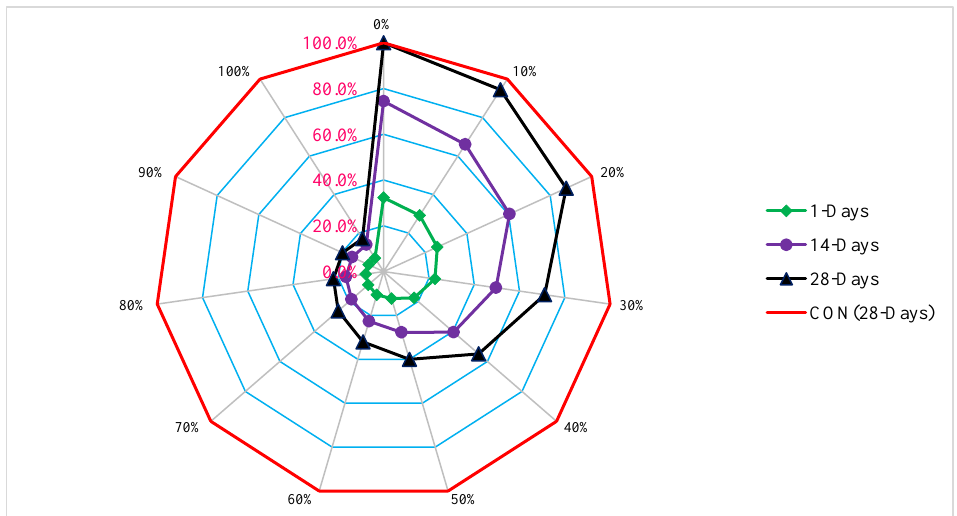
Figure 9. Relative compressive strength.